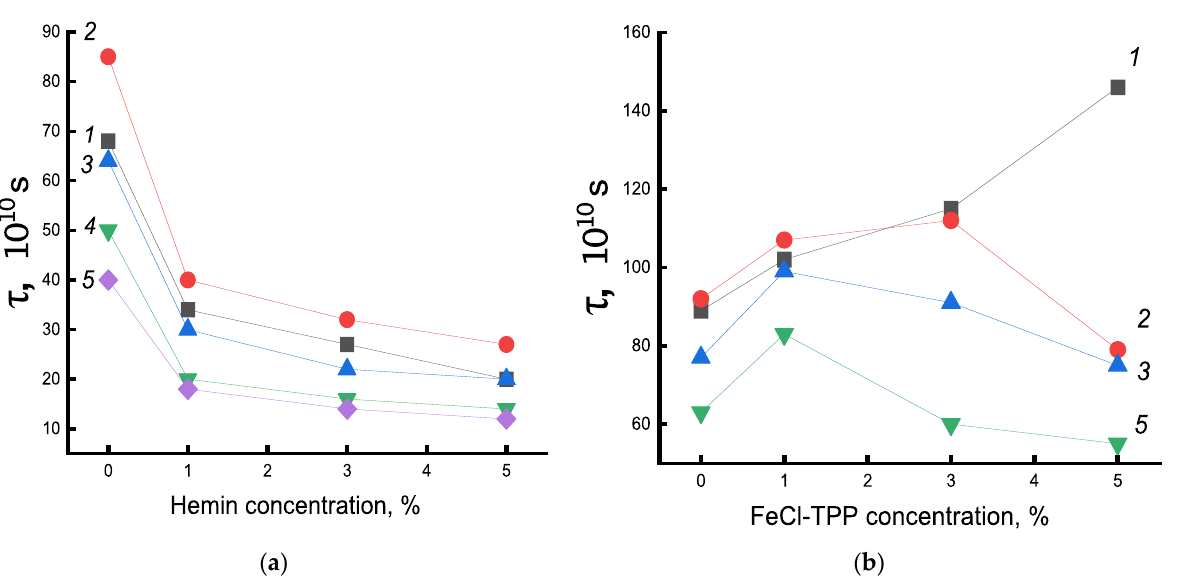
Figure 7. Dependence of τ on the composition of ( a ) PHB/hemin and ( b ) PHB/Fe(TPP)Cl. Exposure time in the aquatic environment at 70 °C: 1 — 0, 2 — 30, 3 — 50, 4 — 90, 5 — 300 min.